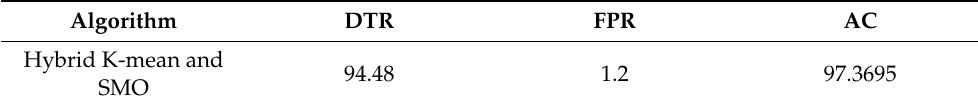
Table 10. Measurement parameters for the hybrid K-mean and SMO method.